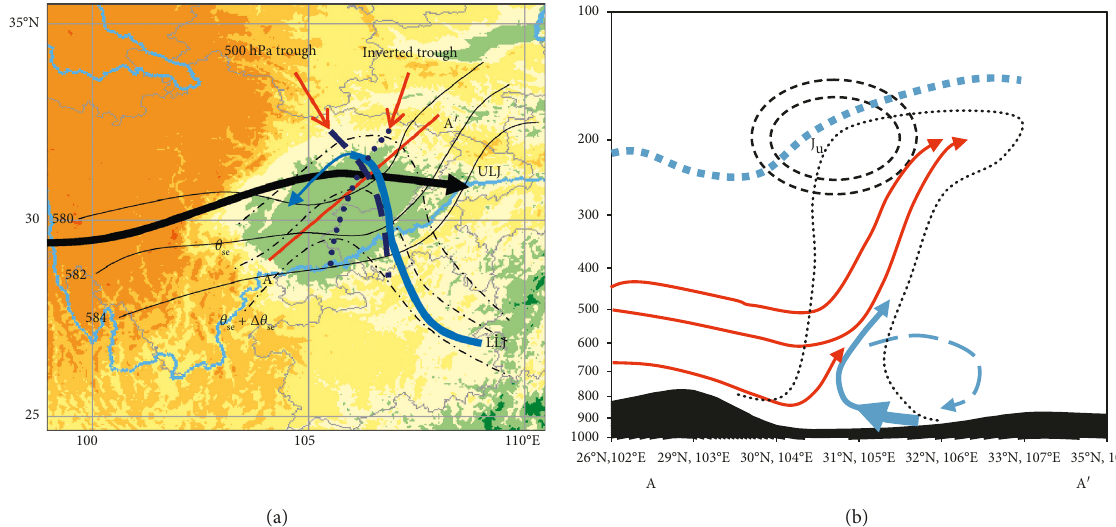
Figure 15: A schematic illustration of weather system configuration (a) and schematic diagram of the vertical circulation (b) in this abnormal heavy rainfall. In (a), LLJ—low-level jet; ULJ—upper-level jet; the solid contours—500hPa geopotential height (units: gpdam); the broken contours—the contours of pseudoequivalent potential temperature ( θ se , units: ° C). In (b), J u —the ULJ